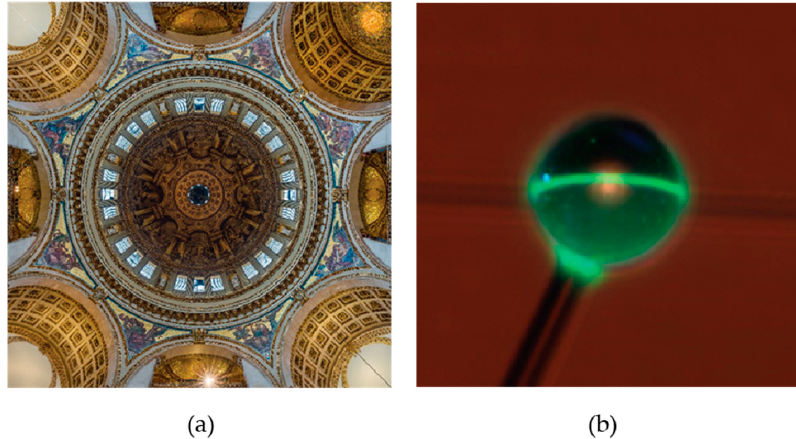
Figure 2. ( a ) A view from underneath the dome of St. Paul’s Cathedral in London. The gallery underneath the dome is an example of an acoustic whispering gallery. Whispering gallery mode optical resonators were named after the acoustic whispering galleries as follows a similar principle, but